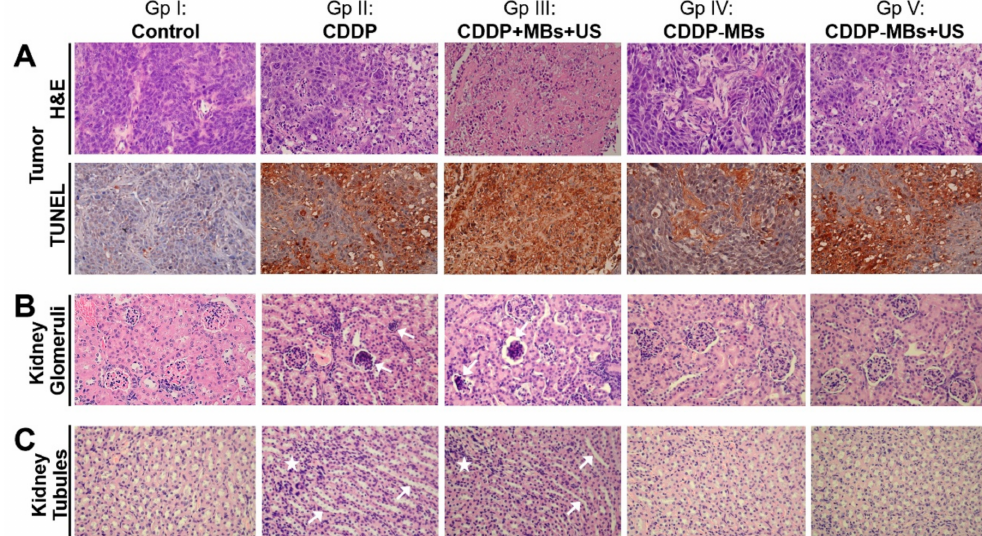
Figure 5. Effects of various CDDP-based chemotherapies on cell death in target tumor tissues and non-target kidney parenchyma. FaDu xenografted tumors and kidneys of SCID mice were